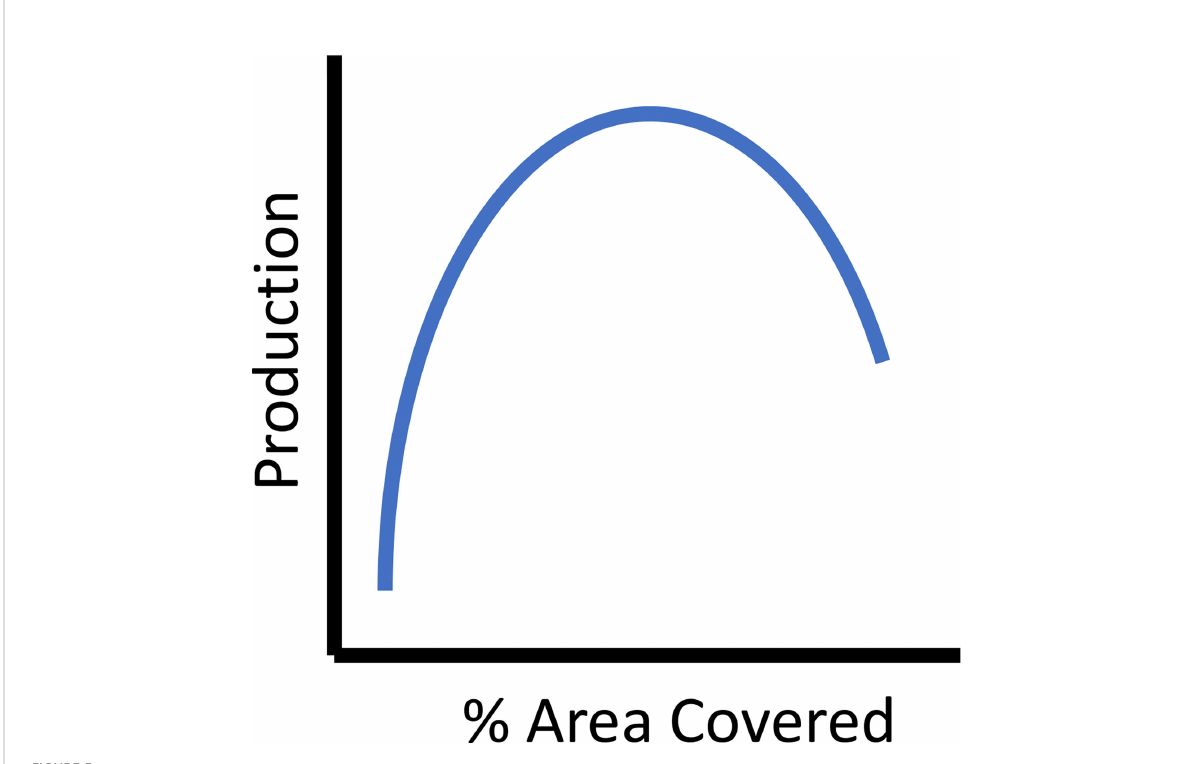
FIGURE 5 The theoretical relationship between percent of area covered, as a metric of reef spacing criteria and secondary ( fi sh)